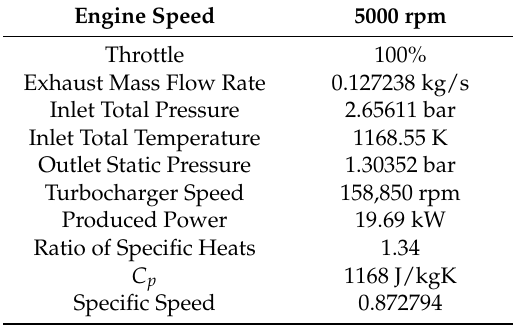
Table 3. Design point boundary conditions from Ricardo WAVE.